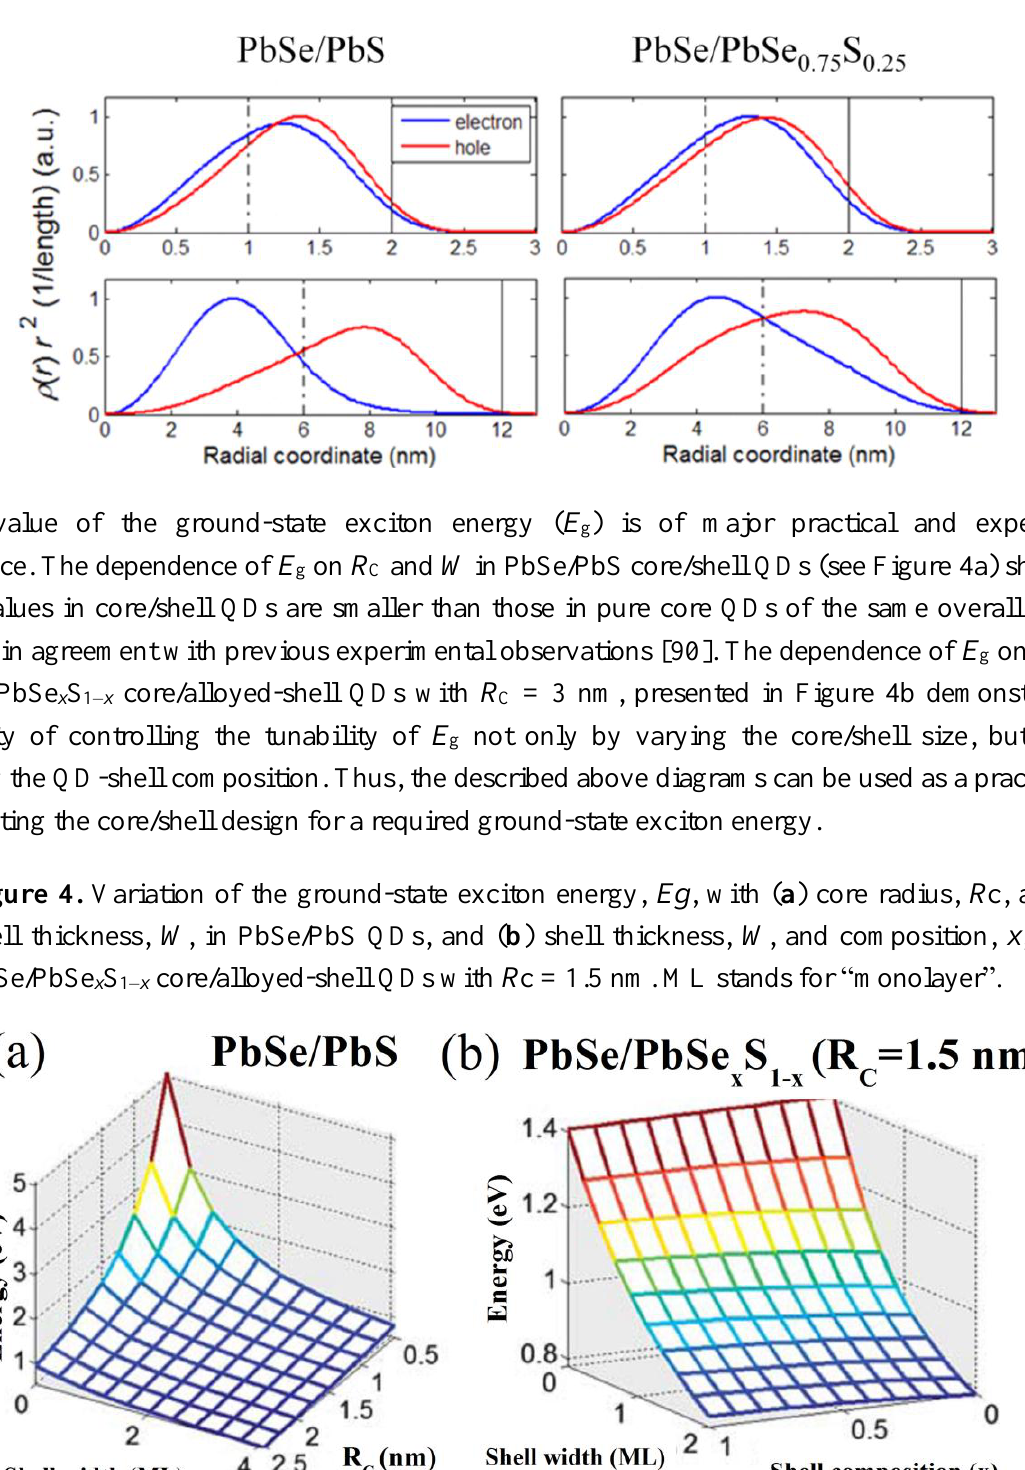
Figure 3. Radial probability density of the ground-state electron and hole in the indicated QD heterostructures. Top row: R c = 1 nm, R s = 2 nm; bottom row: R c = 6 nm, R s = 12 nm. Solid and dashed vertical lines designate the external QD boundaries and the core/shell interface positions, respectively.